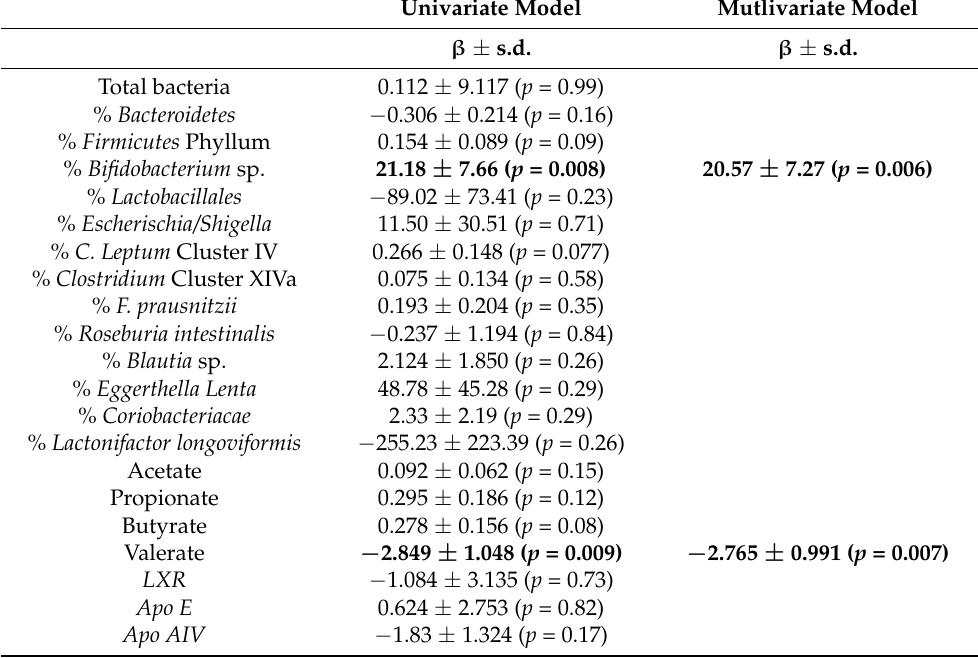
Table 4. Relationship between abundance of given bacterial genes in stools, short chain fatty acids (SCFAs) in fecal water (FW) or Caco-2 cell lipid metabolism gene expression and MCF-7 cell viability after incubation with the basolateral medium of Caco-2 cells exposed to FW from the whole population. Univariate Model Mutlivariate Model β ± s.d.